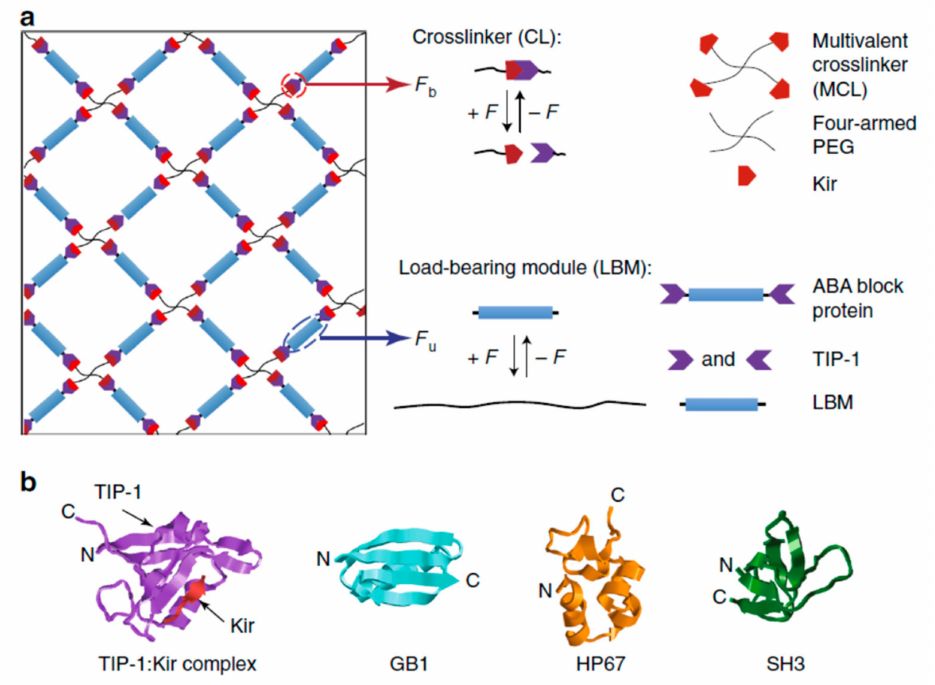
Figure 5. Design of hydrogel networks with mechanical properties similar to naturally occurring tissues: ( a ) The hydrogel network is formed from two mechanical responsive elements: cross-linkers (CLs) and load-bearing modules (LBMs). The binding / unbinding kinetics of the CL and the folding / unfolding of the LBM are regulated by the applied mechanical force; ( b ) Structure of the protein domains (LBMs) used in the hydrogel design to form the TIP-1:Kir complex: GB1, HP67, and SH3 [178]. The figure